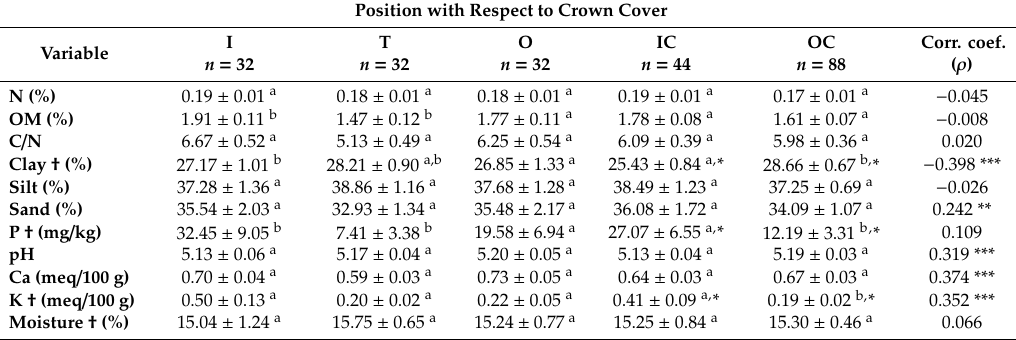
Table 2. Edaphic variables. Mean values (mean ± standard error) according to sample grid and position respect to tree crown cover. n : total number of samples. I: inside crown grid; T: transition grid; O: outside crown grid. IC: samples inside crown cover; OC: samples outside crown cover; ( ρ ): Spearman correlation coe ffi cient between cfu ( n = 132) and physicochemical soil parameters. Di ff